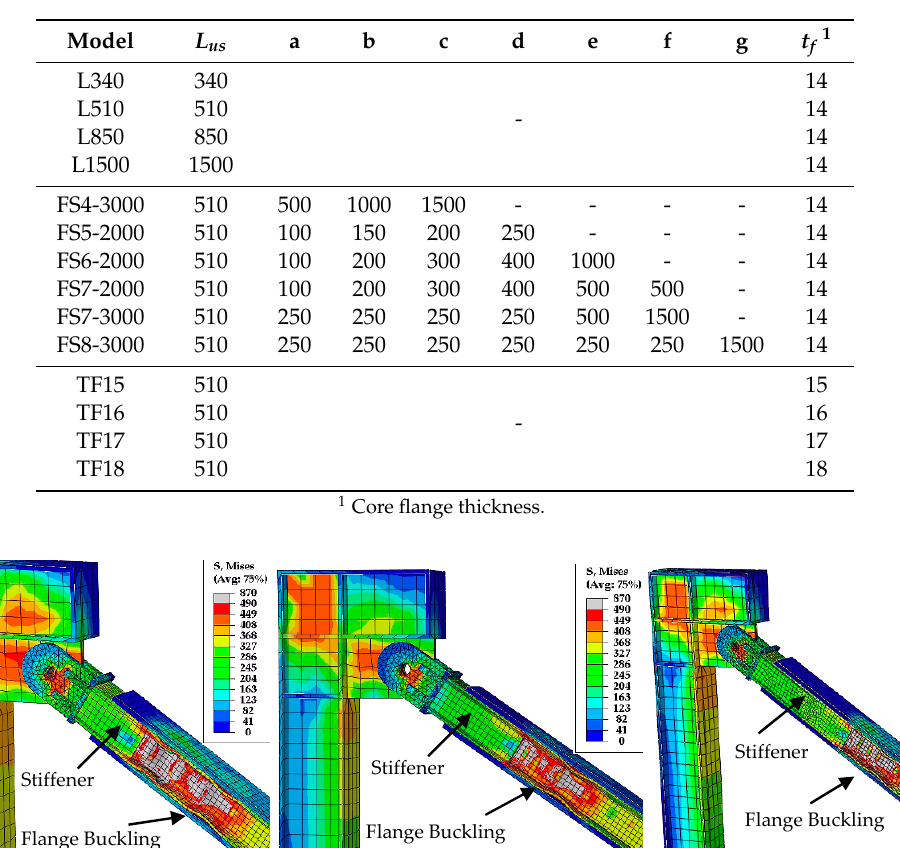
Figure 12. Variables of the parametric study. Table 4. Details of the finite element model.